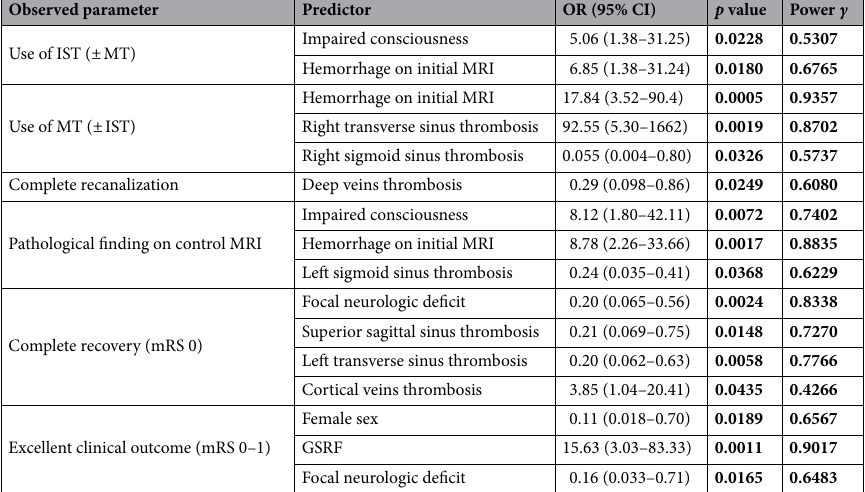
Table 3. Significant independent predictors of the observed parameters in the whole set of 82 patients— results of multivariate logistic regression analysis. Values are expressed as OR (95% CI). Significant p values are indicated in bold. CI confidence interval, GSRF gender-specific risk factors, IST intrasinus thrombolysis, MRI magnetic resonance imaging, mRS modified Rankin Scale, MT mechanical thrombectomy, OR odds ratio, rtPA recombinant tissue plasminogen